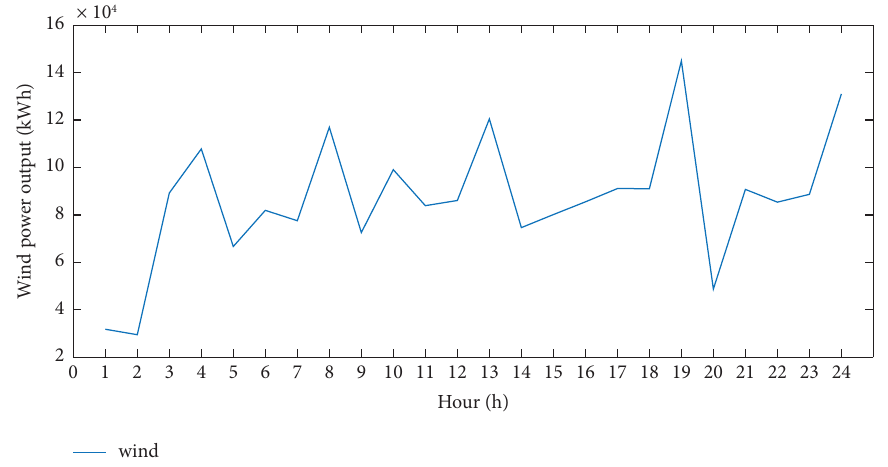
Figure 5: Wind power output in energy of users is high every day. From 00:00 a.m.–6:00 a.m., Figure 17 is exergy input of system with AA-CAES of the exergy input remains at a low level, because users typical day in diferent seasons. Te system maintains a high generally have relatively low energy demand during this and stable exergy input from 7:00–21:00 in typical day of period. From 5:00–8:00 is the period when the system exergy three seasons. During this time period, the demand for